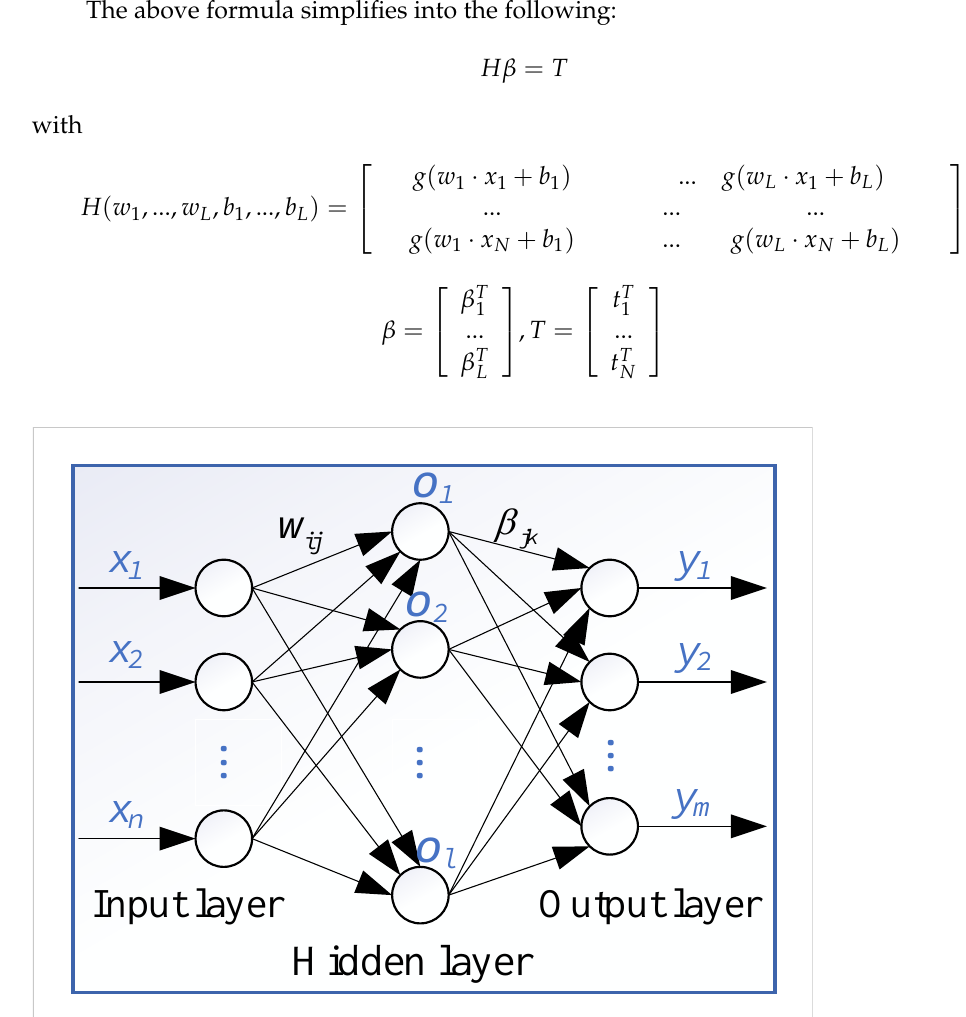
Figure 6. The structure of